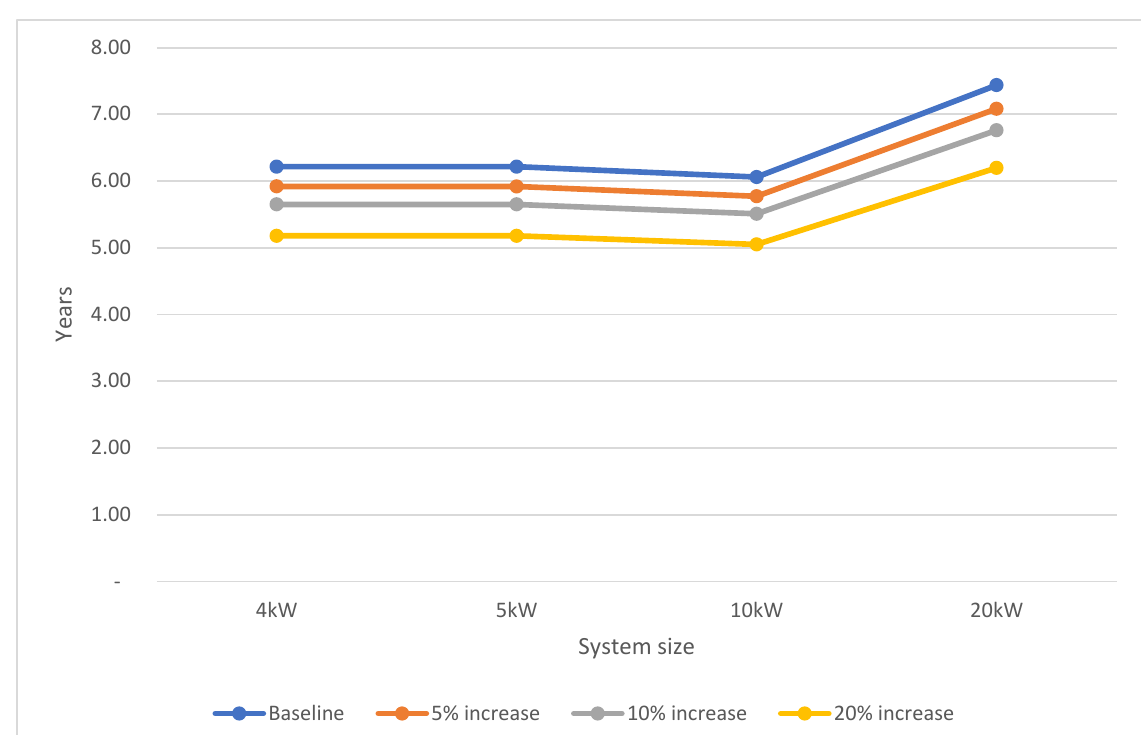
Figure 5. Changes to net savings to the changes in electricity tariffs.